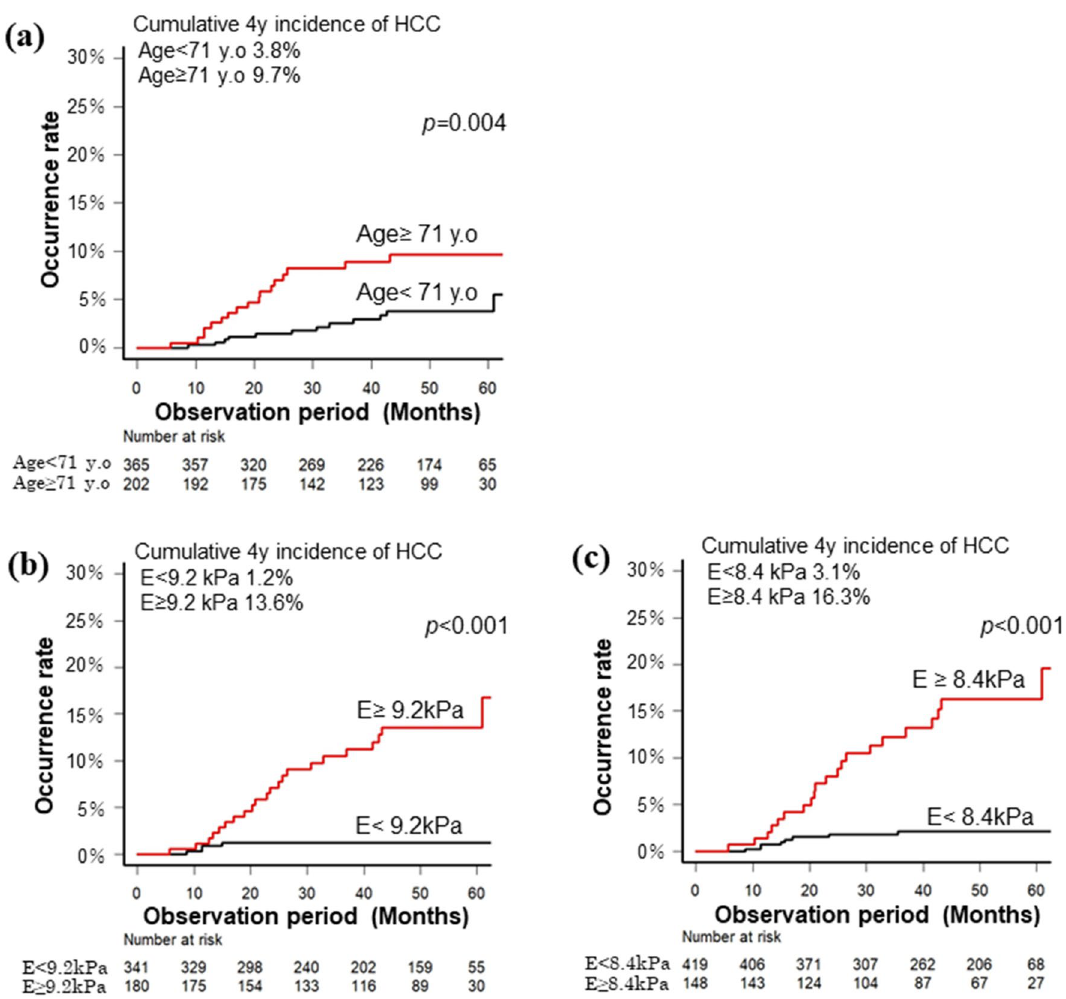
Figure 3. Cumulative incidence of hepatocellular carcinoma after IFN-free treatment according to factors contributing to HCC. Cumulative incidence of hepatocellular carcinoma according to ( a ) age of 71 years as a cut-off value. The black line indicates patients younger than 71 years, and the red line indicates patients aged > 71 years. ( b ) LSM before treatment with 9.2 kPa as the cut-off value. The black line indicates cases with LSM < 9.2 kPa, and the red line indicates those with LSM > 9.2 kPa. ( c ) LSM at the time of SVR24 with 8.4 kPa as the cut-off value. The black line indicates cases with LSM < 8.4 kPa, and the red line indicates those